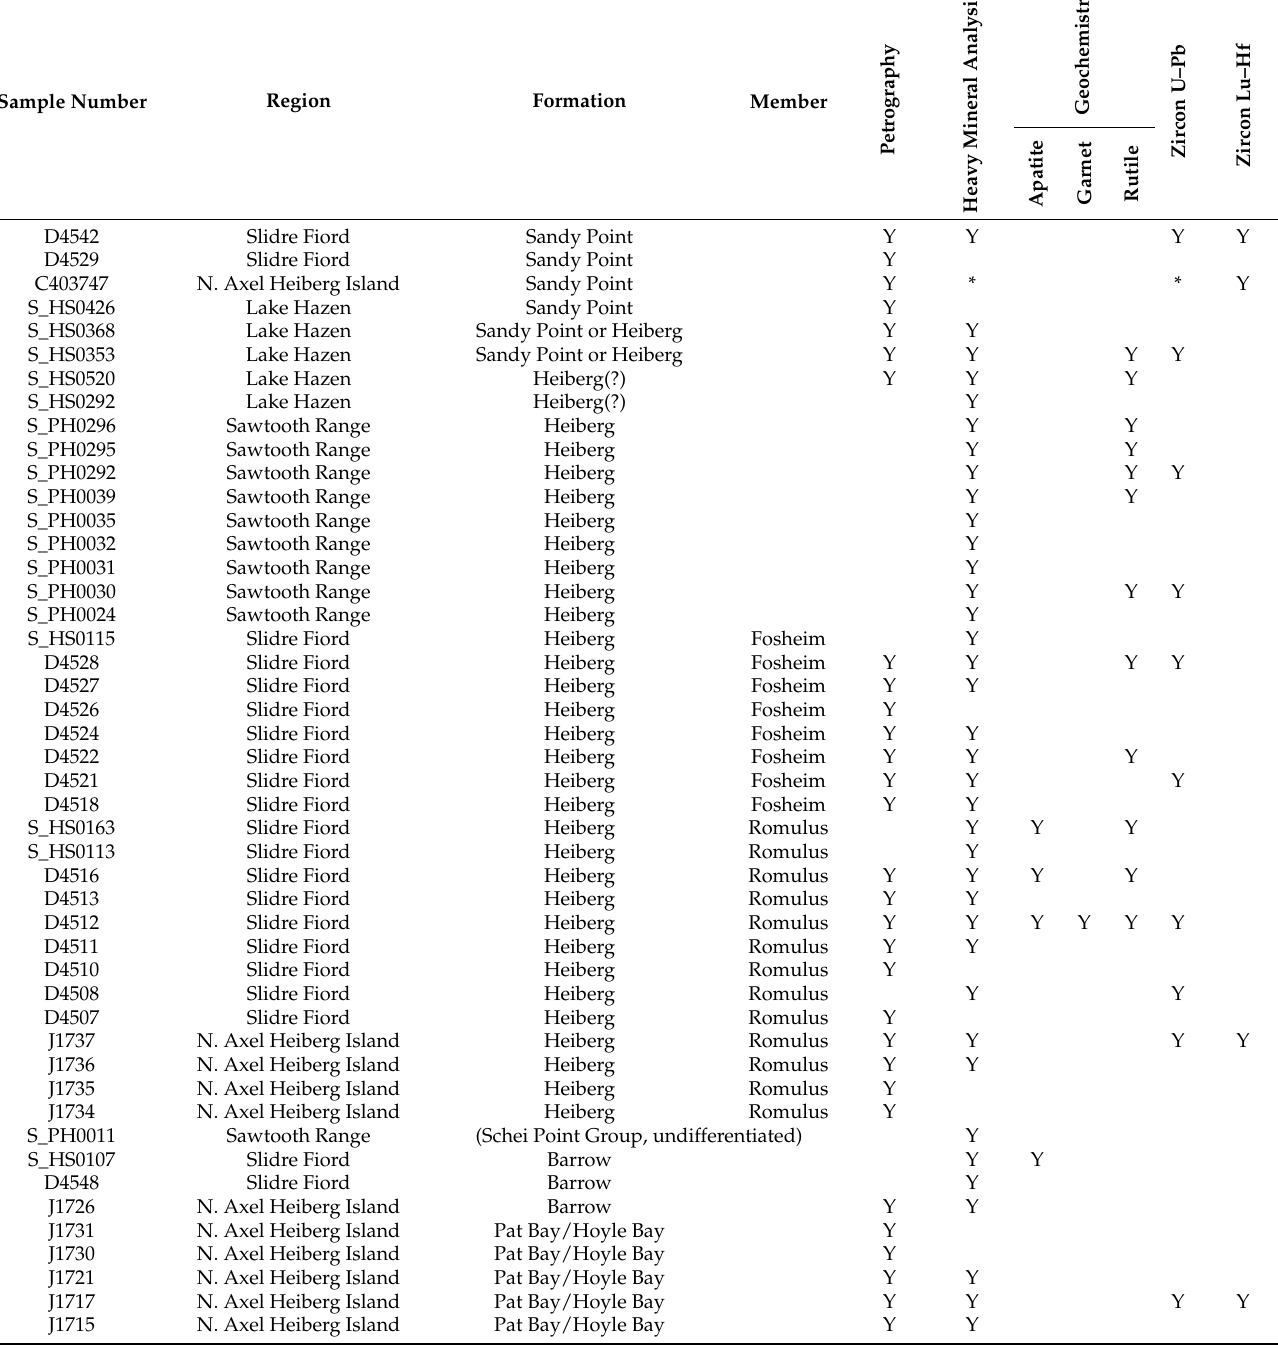
Table 1. A list of the samples studied and the analyses undertaken. All samples are sandstones apart from D4548, J1703, J1740, S_HS0292 and S_HS0631 (siltstones), as well as S_HS0250 and S_HS0640 (limestones). Further lithological information and sampling co-ordinates are provided in the supplementary materials (Table S1). * Data were presented by Omma et al.